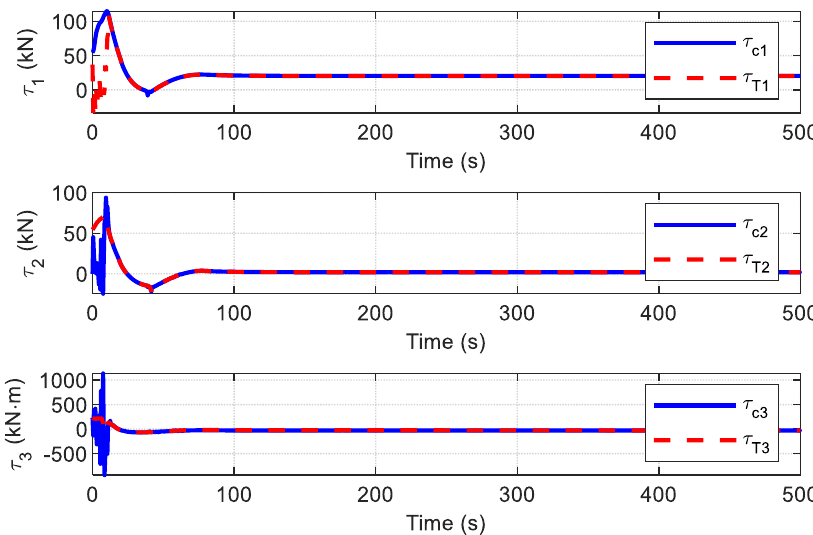
Figure 16. Control inputs τ c and thruster forces τ T